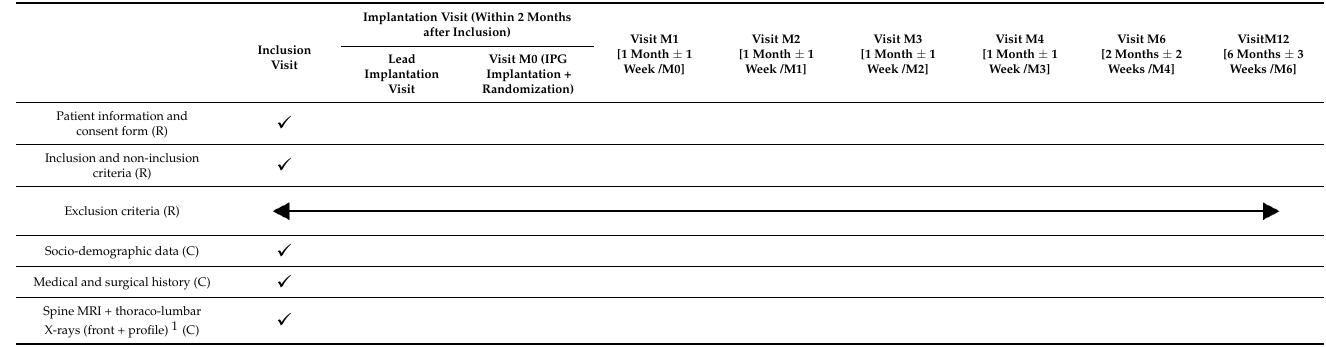
Table 1. Radio-clinical assessment calendar.